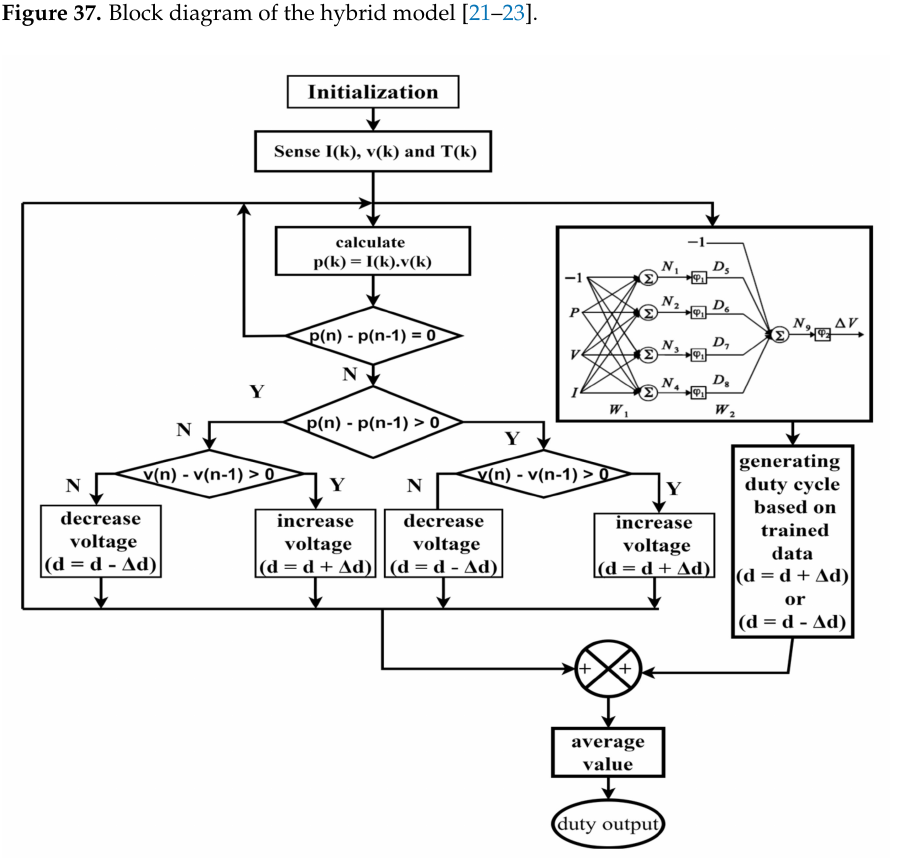
Figure 38. Flow chart for hybrid MPPT based on neural network and P&O